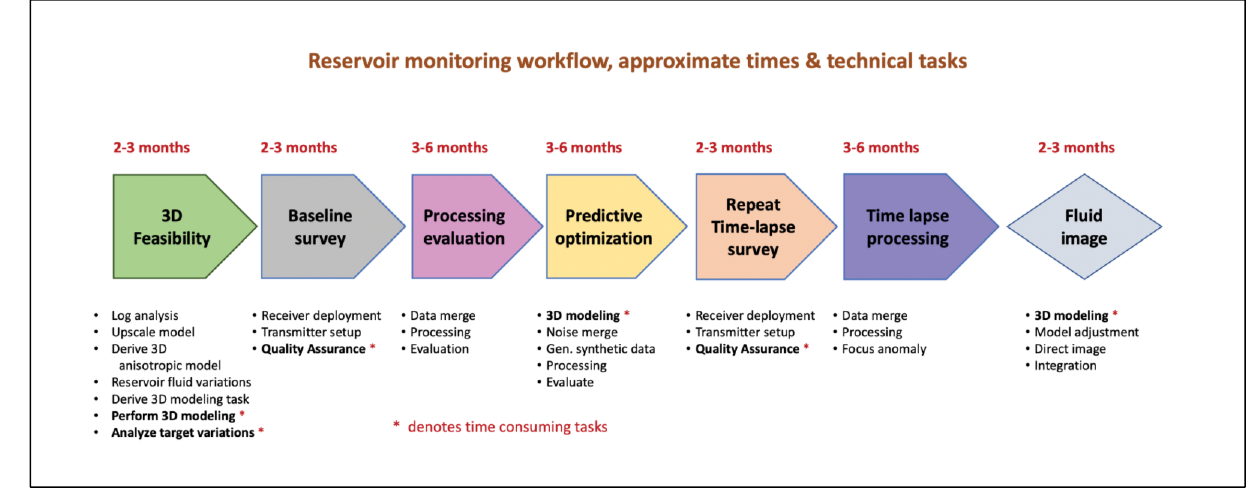
Figure 1. Workflow of a typical electromagnetic reservoir monitoring project. Below the flow block are the major tasks in each step.